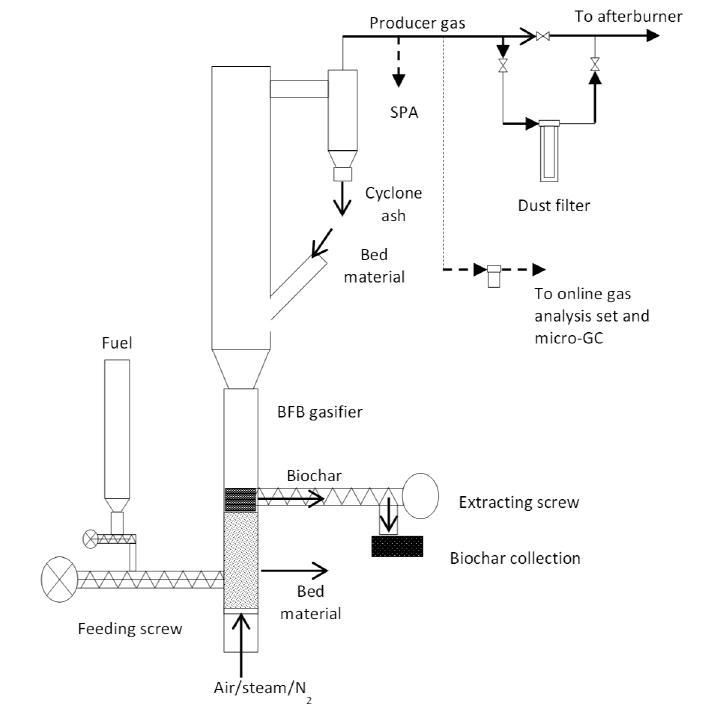
Figure 2. Schematic layout of the small lab scale bubbling fluidized bed gasification reactor at ECN. The fluidizing agent keeps the sand bed in motion, which results in a very even temperature distribution. It avoids temperature peaks at the introduction of the